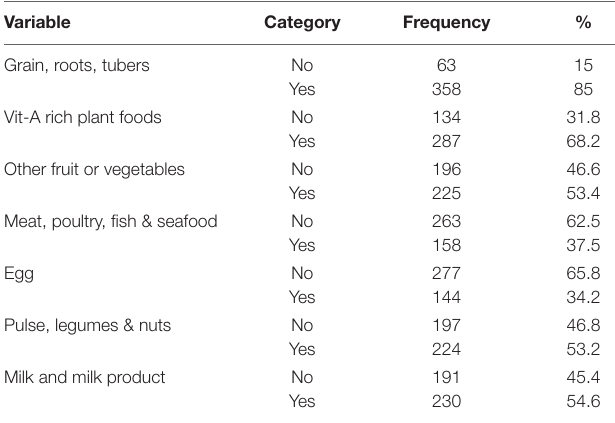
TABLE 3 | Dietary diversity habits of children 6–23 months, Dessie Town, South Wollo Zone, Northeastern Ethiopia, 2021.